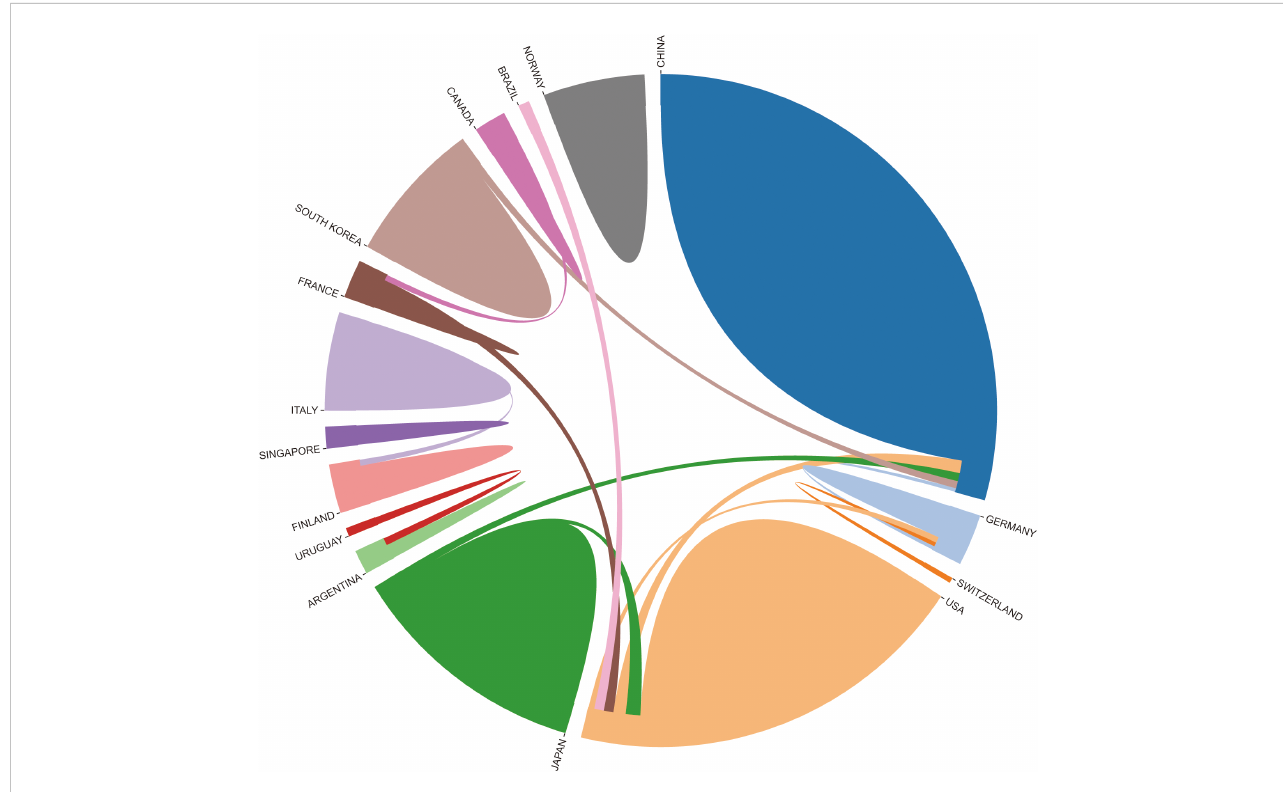
FIGURE 12 Country-to-country relations of Top 100 Most-cited Articles.